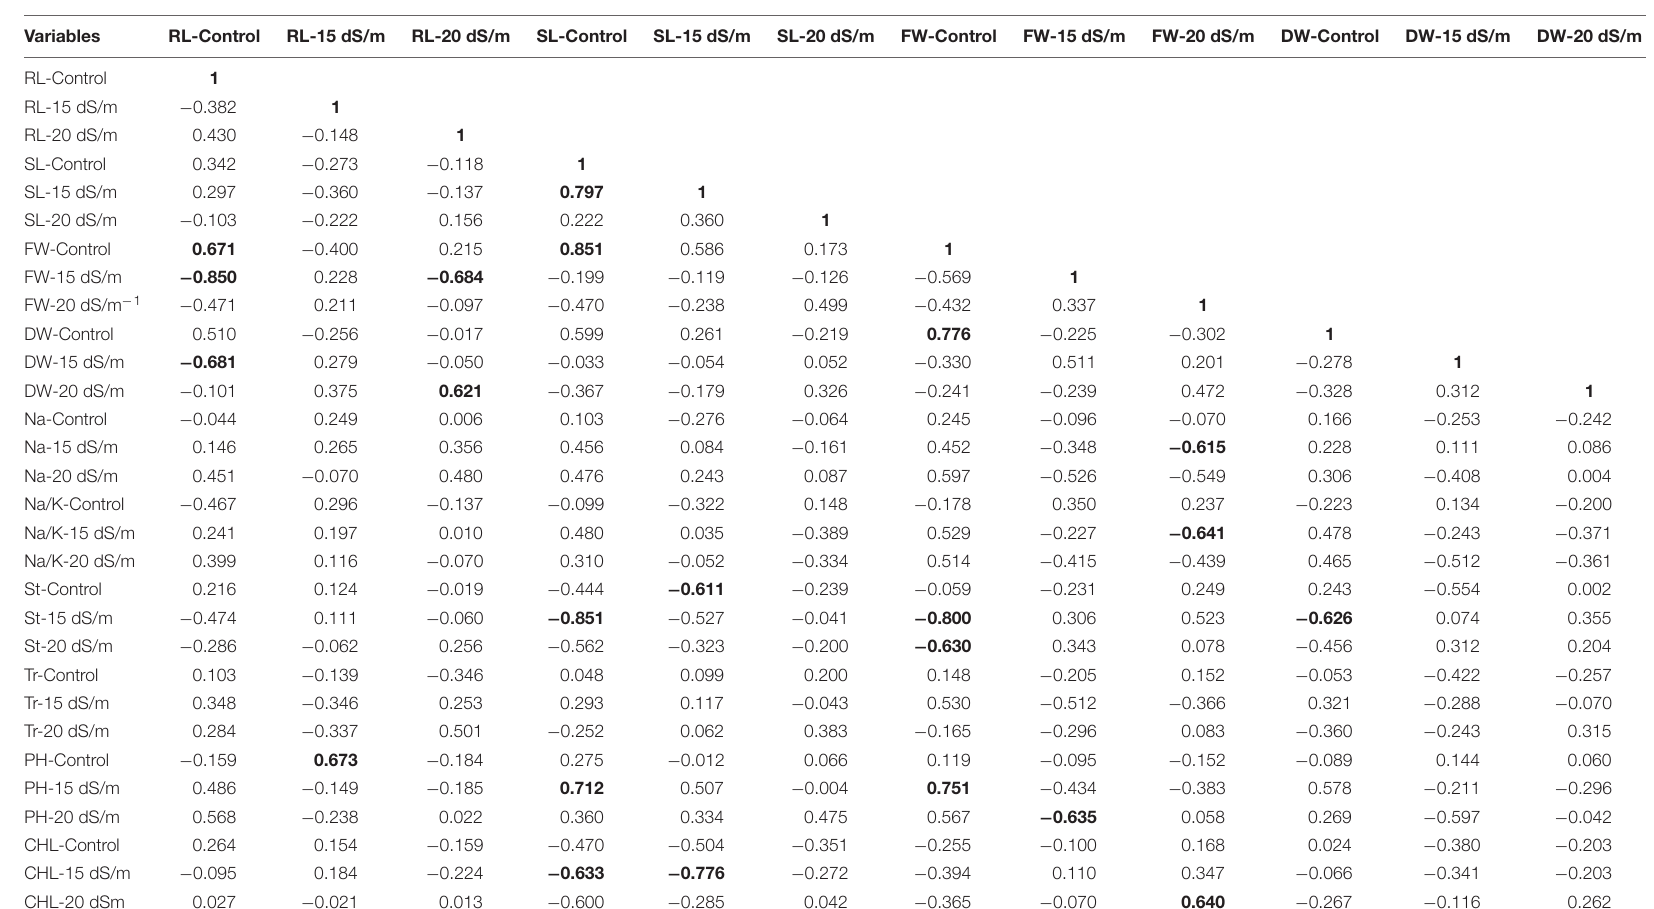
TABLE 8 | Correlation matrix for morphological traits under control and salt stress conditions.